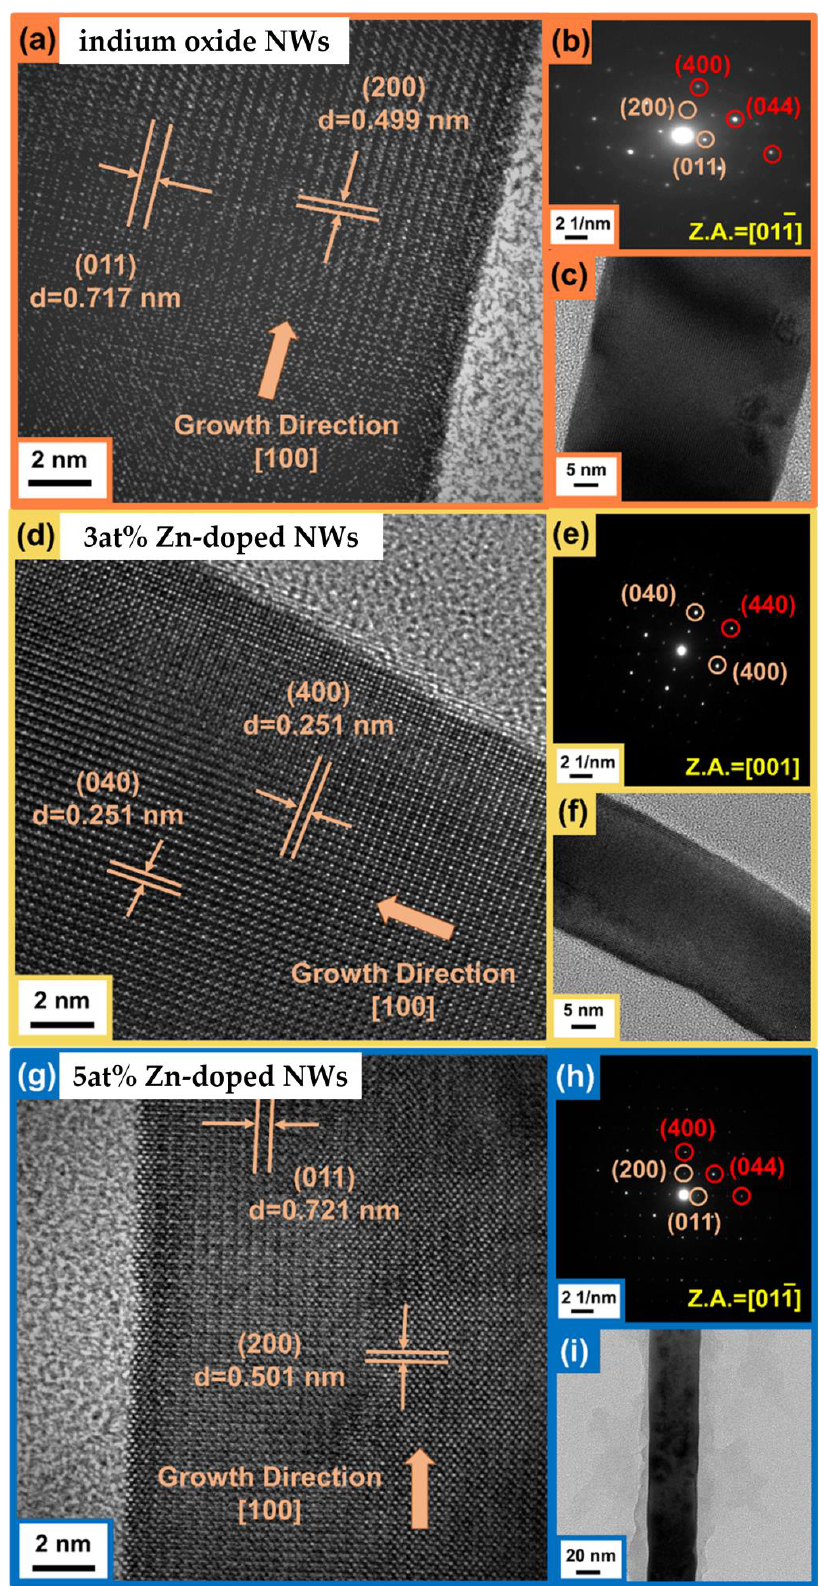
Figure 5. TEM analysis of single nanowire: ( a ) 800k HRTEM image; ( b ) SAED pattern; ( c ) 300k HRTEM image of In 2 O 3 nanowire; ( d ) 800k HRTEM image; ( e ) SAED pattern; ( f ) 300k HRTEM image of 3 at% Zn-In 2 O 3 nanowire; ( g ) 800k HRTEM image; ( h ) SAED pattern; ( i ) 300k HRTEM image of 5 at% Zn-In 2 O 3